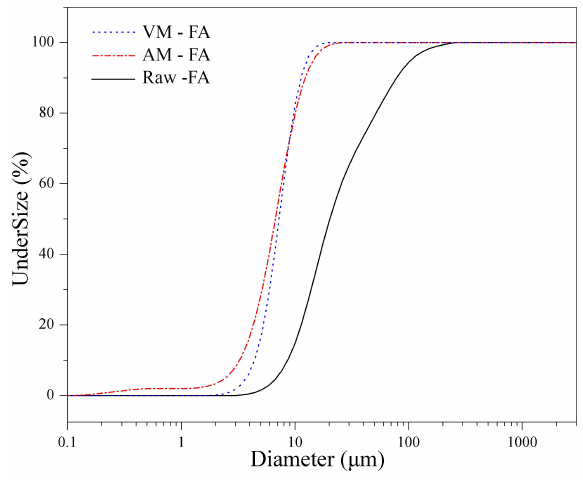
Figure 1: Particle size distribution of the raw and milled fly